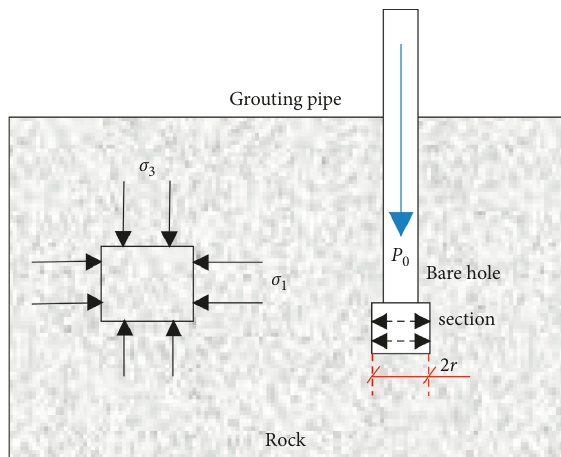
Figure 2: Force diagram of a bare hole during fracture